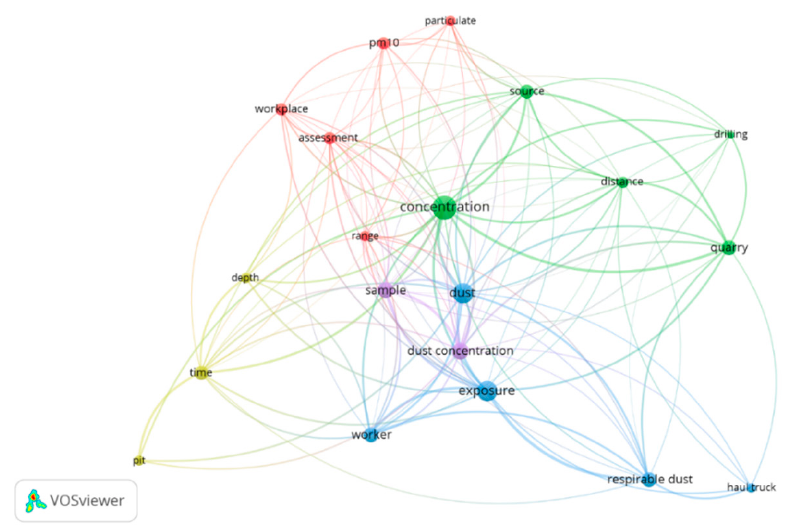
Figure 2. Keywords relations between studies.